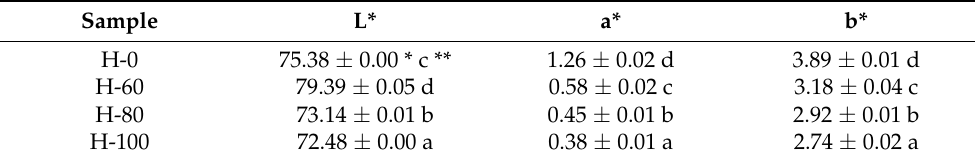
Table 1. Color properties (L*, a*, and b*) of native adlay flour (H-0) and pre-gelatinized adlay